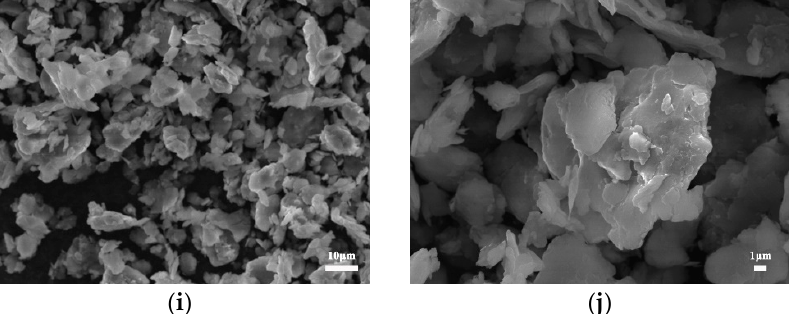
Figure 1. SEM morphology of magnesium powder after grinding for different times. ( a , b ) as-received, ( c , d ) 15 h, ( e , f ) 30 h, ( g , h ) 45 h and ( i , j ) 60 h.